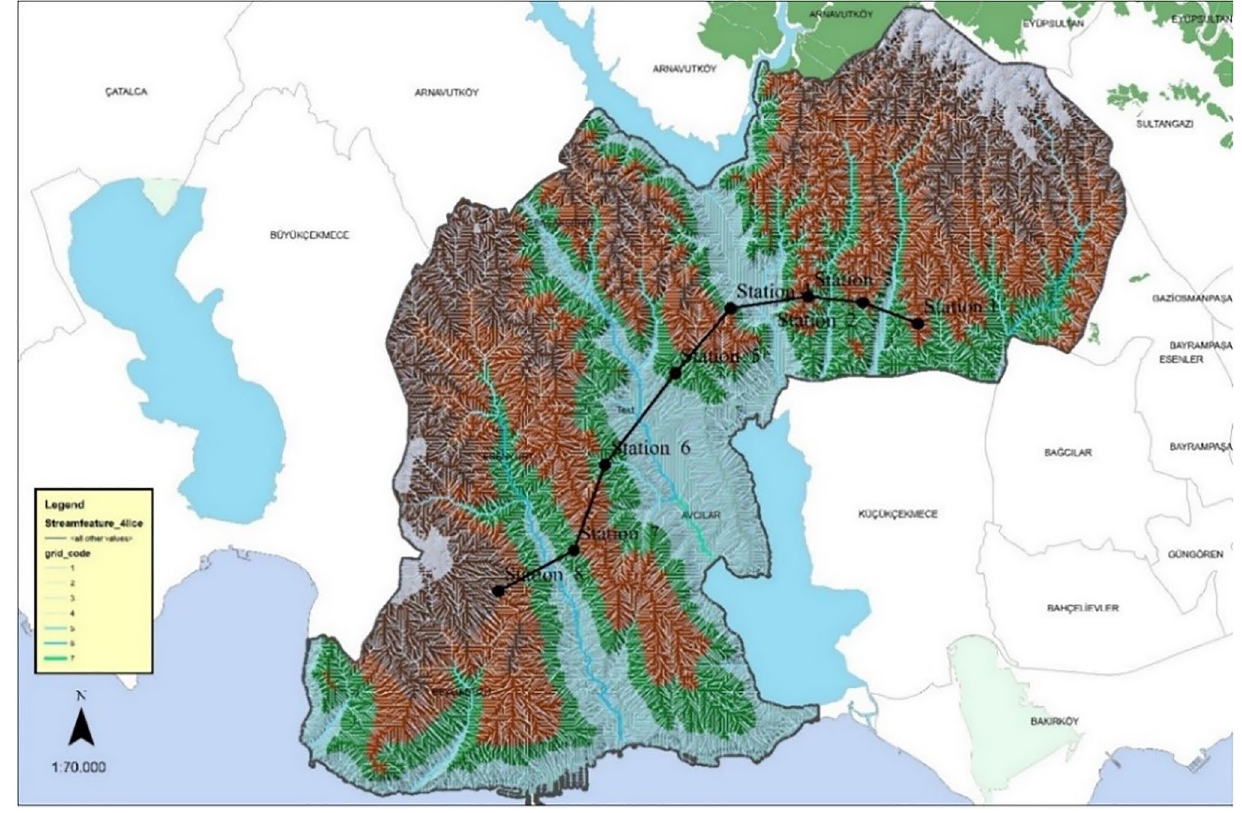
Fig. 4 Stream network (illustrated by